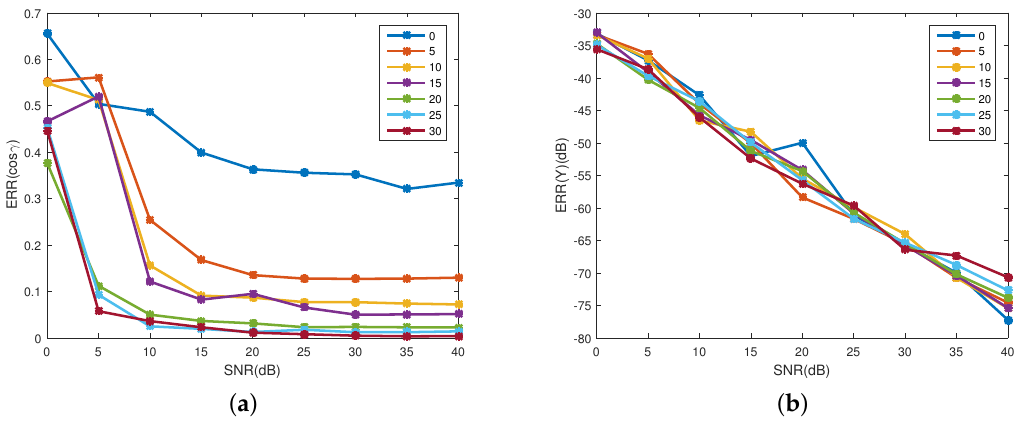
Figure 11. Estimating error of the projecting feature at different coning angles. ( a ) shows the estimating error of the observing angles; and ( b ) depicts the estimating error of the corresponding emissivity-area products. Different colors represent different coning angles, which range from 0 ◦ to 30 ◦ with step of 5 ◦ .